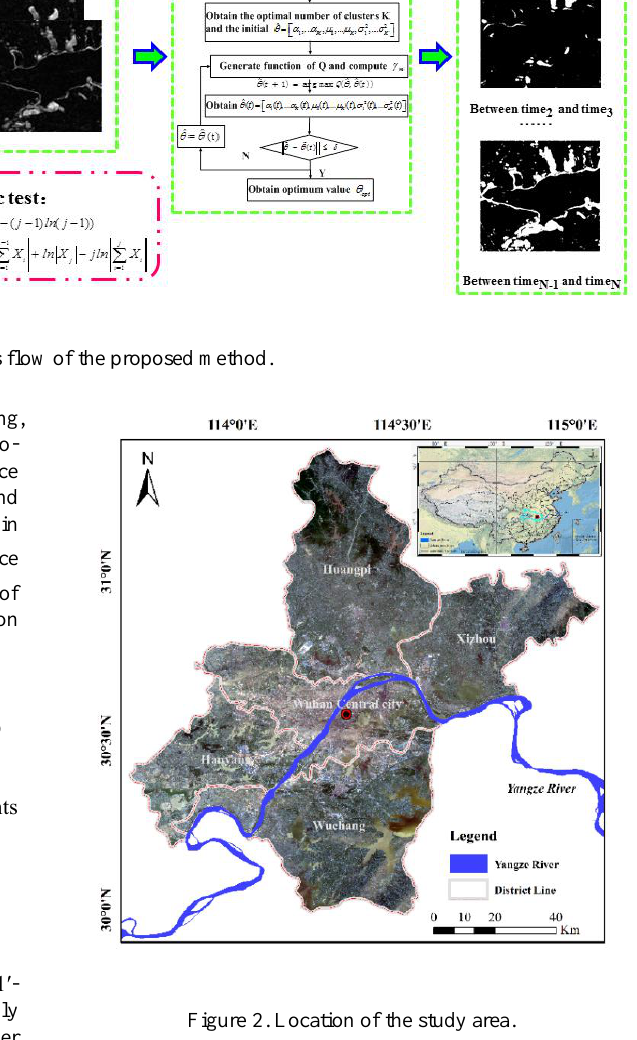
Figure 2. Location of the study